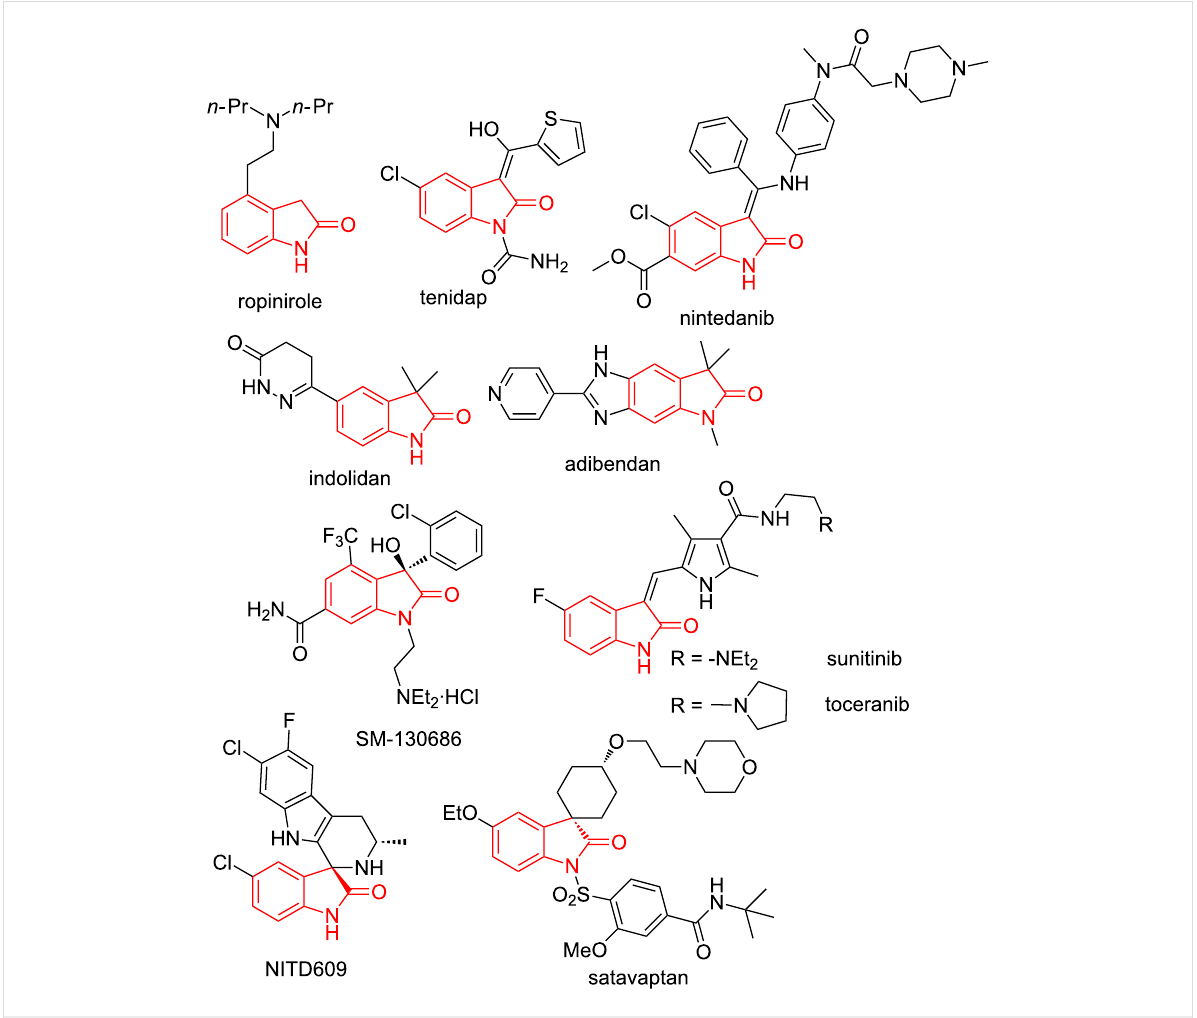
Figure 5: Drugs and biologically active compounds bearing a 2-oxindole